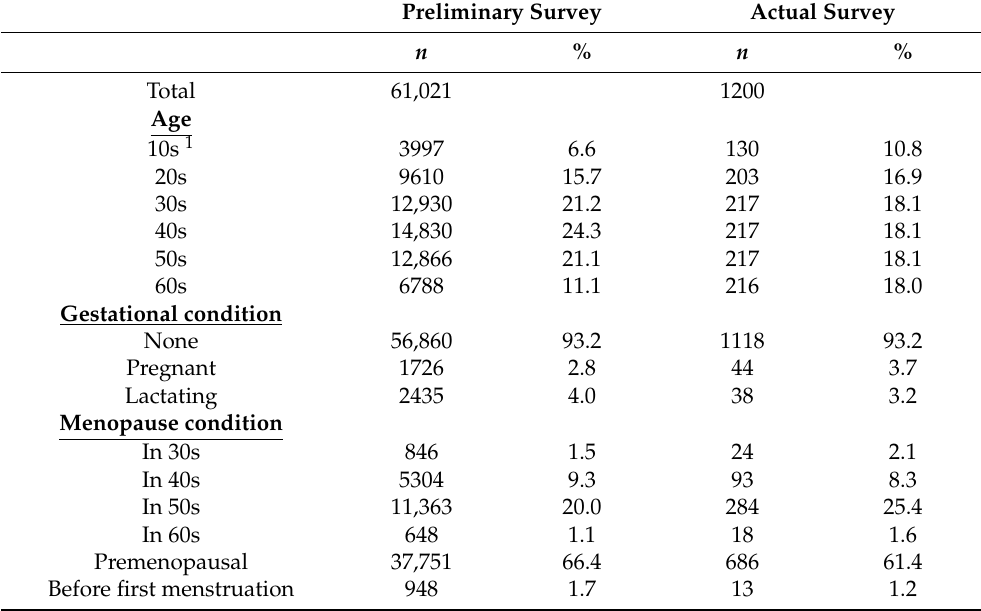
Table 1. Characteristics of the